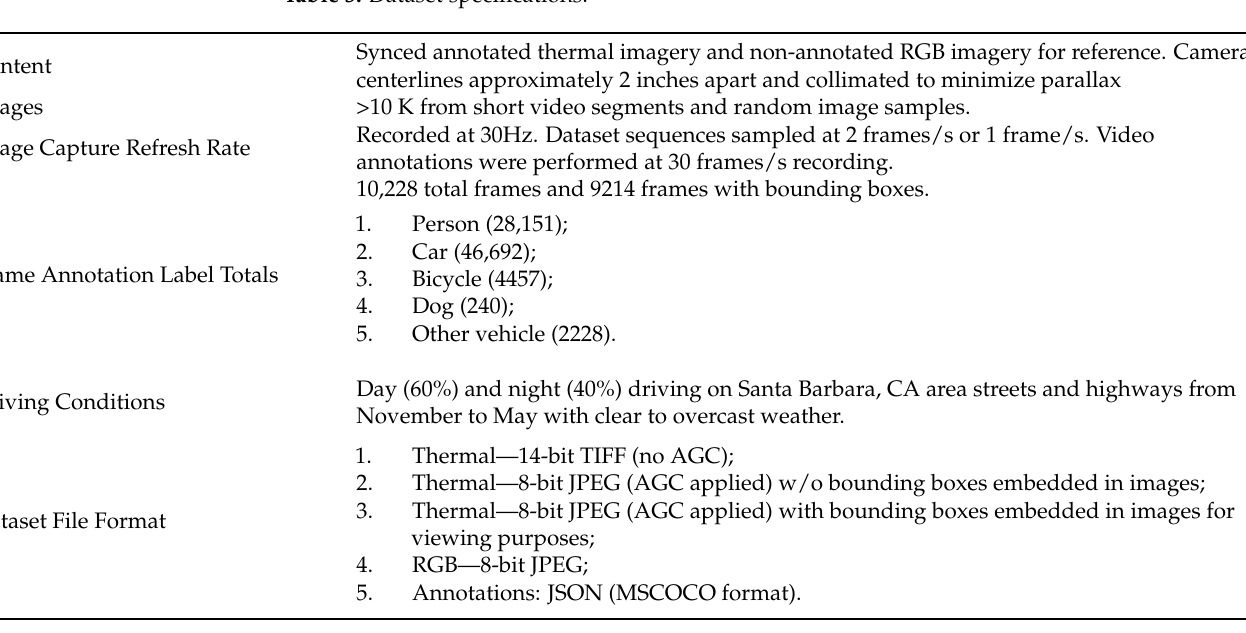
Table 3. Dataset